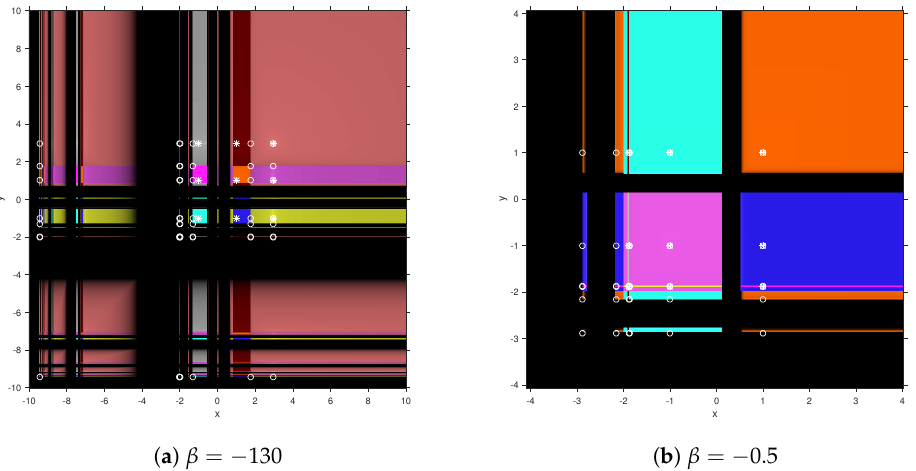
Figure 7. Dynamical plane for unstable values of β of class M41 on p ( x )